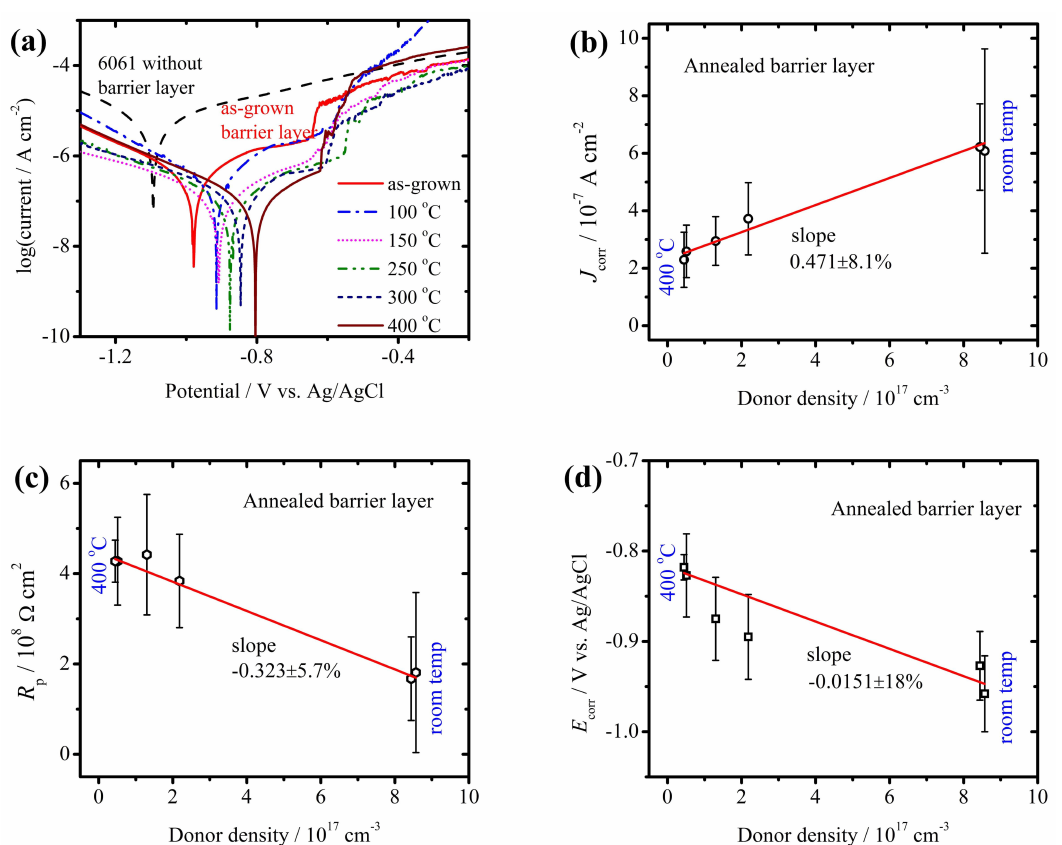
Figure 4. Potentiodynamic polarization curves of the AAO and correlations between corrosion parameters and donor density. ( a ) Potentiodynamic polarization curves at scan rate 5 mV · s − 1 show the anticorrosion trend. Linear correlation is displayed between ( b ) corrosion current, ( c ) polarization resistance of the AAO layer and its donor density. Considerable deviation is shown in the correlation between ( d ) corrosion potential and donor